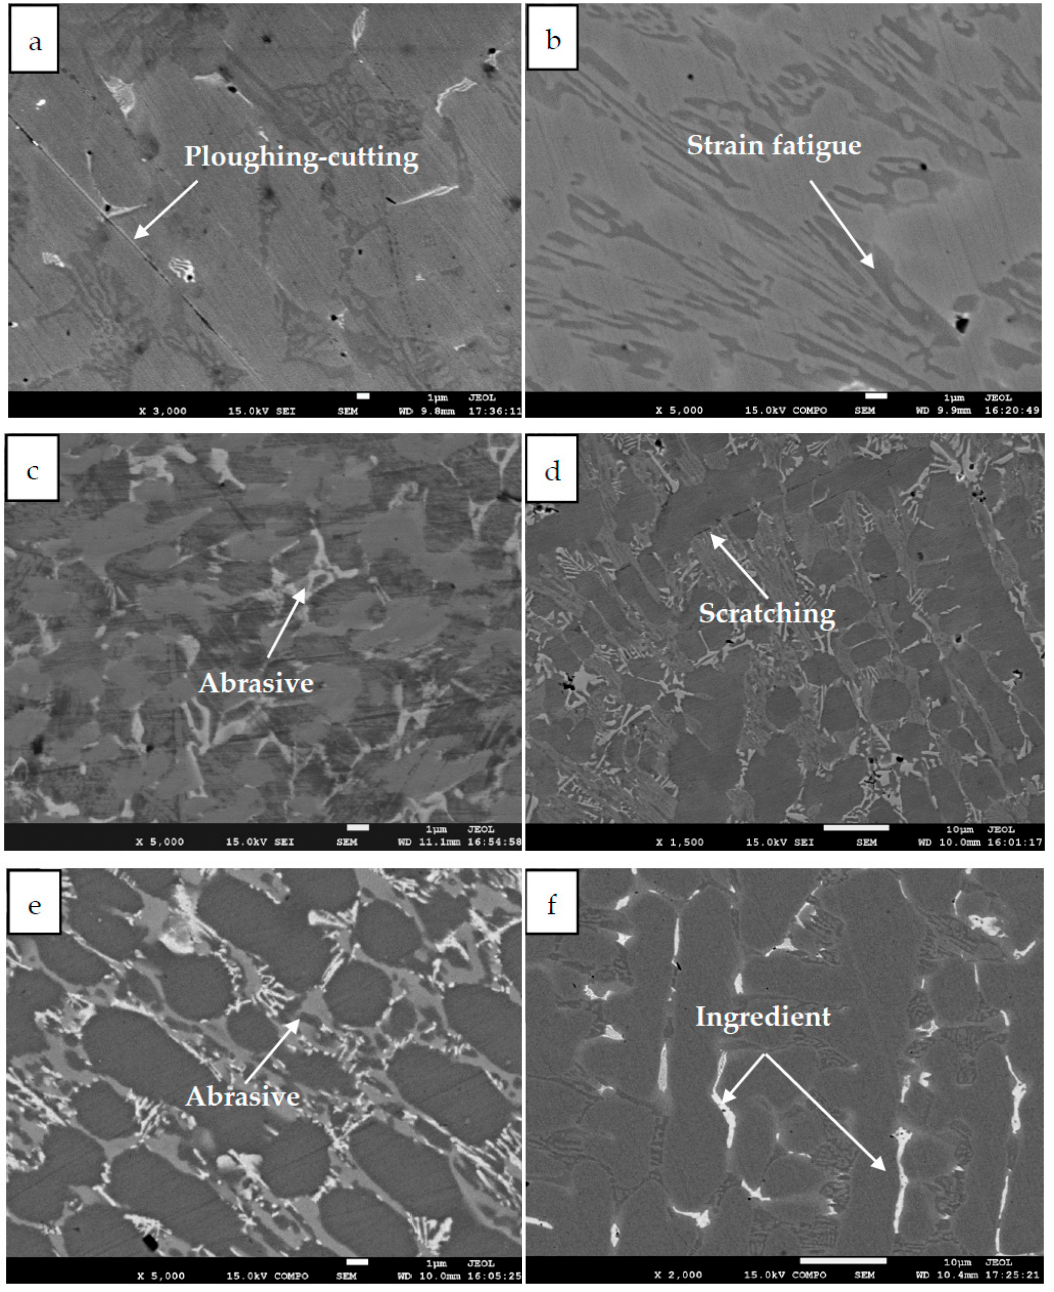
Figure 5. SEM morphologies of worn surfaces: ( a ) I, ( b ) II, ( c ) III, ( d ) IV, ( e ) V, and ( f ) counterpart under fluid dynamic lubrication condition at the slide speed of 0.5 mm / s and pressure of 27.22